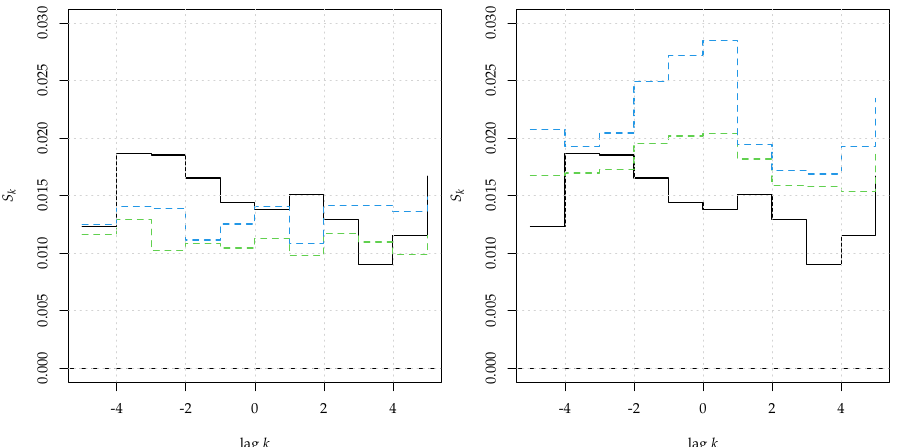
Figure 7. Cross Entropy S k for k = − 5, . . . ,5 (black, solid line), computed between two inde- pendent realizations of a AR(1) process. The rejection bands at 95% and 99% are indicated as green and blue dashed lines, respectively. In the left panel they are computed by permutation ( ci.type=‘perm’ ), whereas in the right panel the bands are computed through a moving block bootstrap ( ci.type=‘mbb’